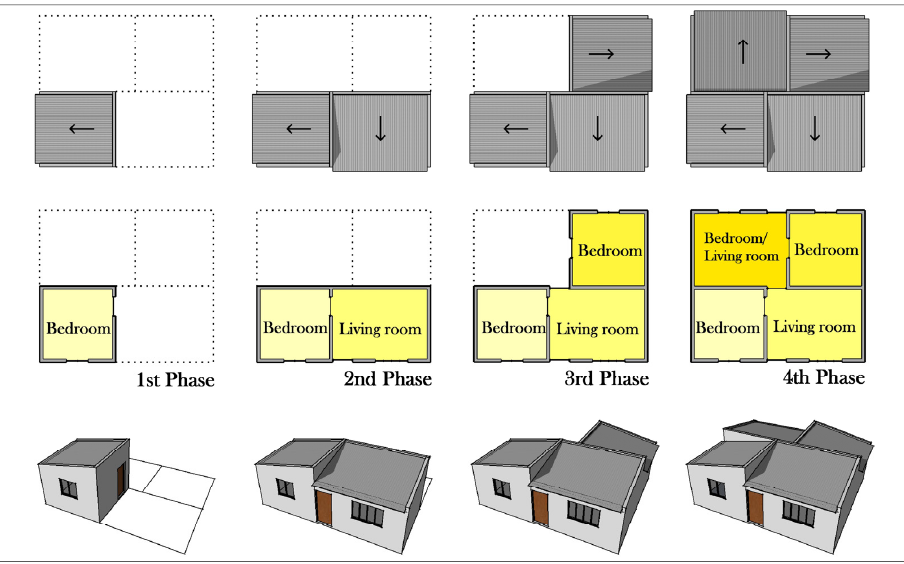
Figure 15. Fan House, the standard housing typology found in Maputo’s informal settlements